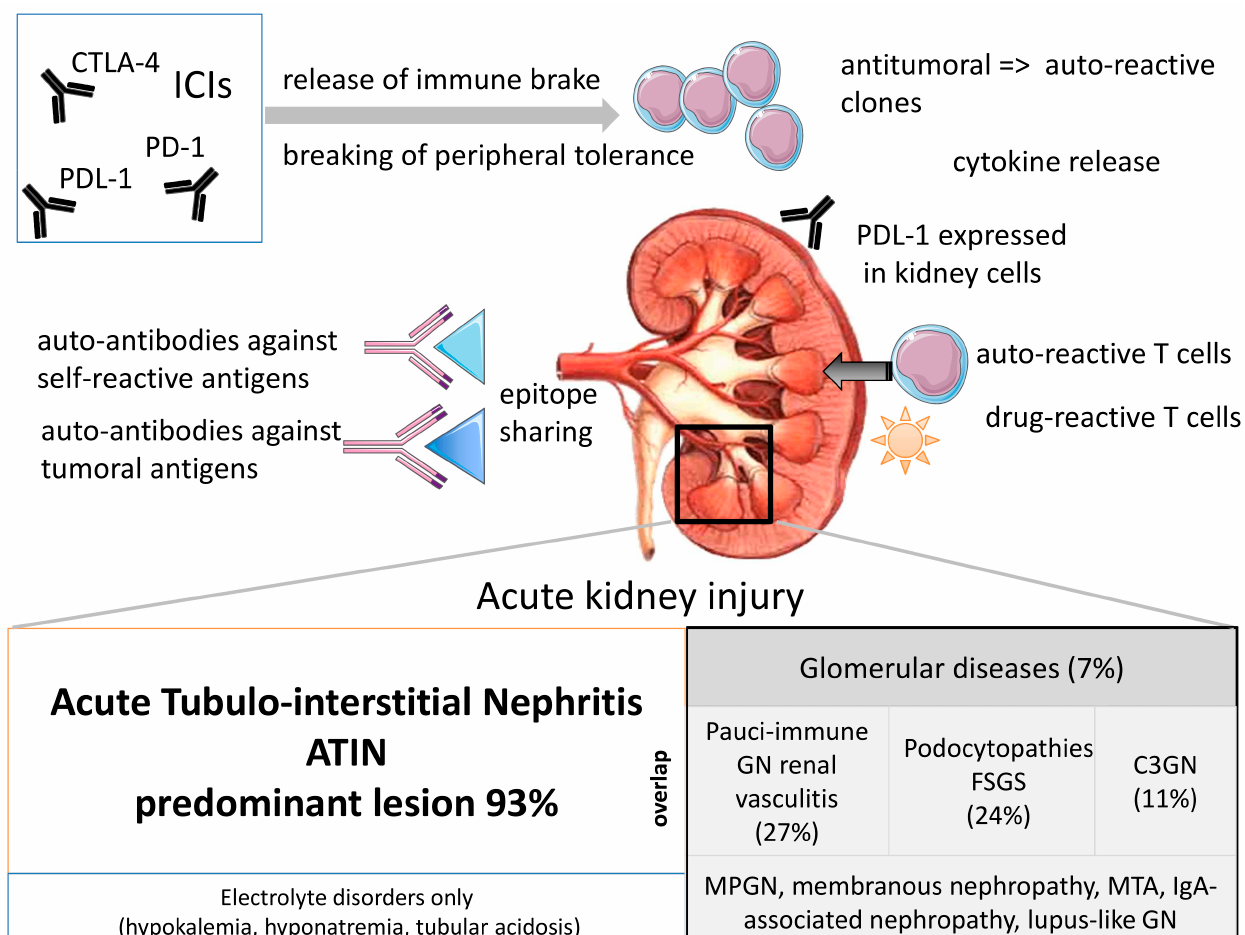
Figure 1. ICI-related renal complications: pathophysiology and landscape. While releasing the immune brake, ICIs lead to a disruption in peripheral tolerance. Through several mechanisms implicating both cellular and humoral immune responses, ICIs may lead to acute kidney injury. The predominant lesion is acute tubulo-interstitial nephritis (ATIN). Some glomerular diseases and electrolyte disorders have also been described.